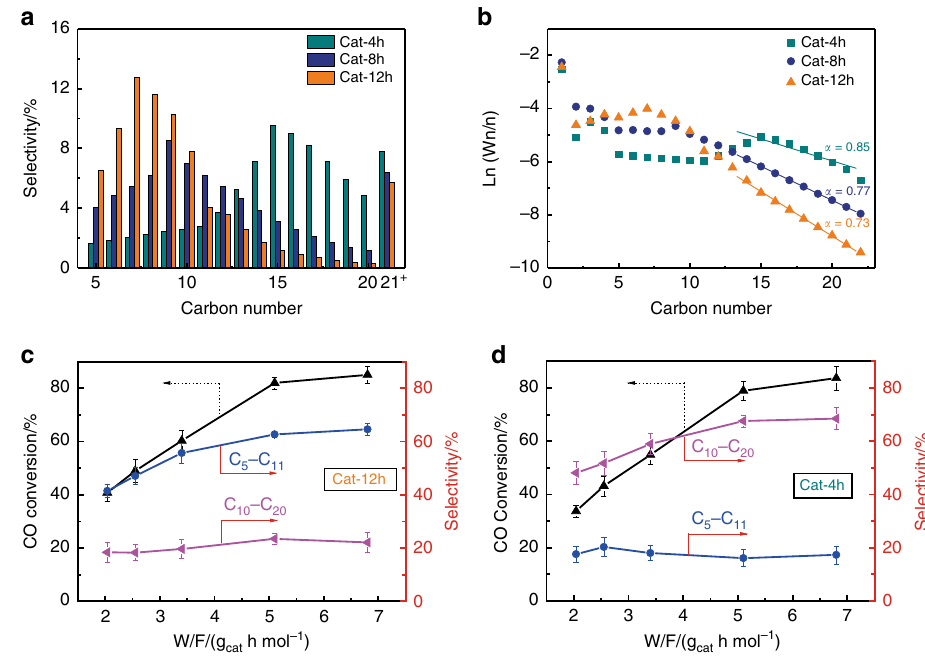
Fig. 5 FTS performance of the Cat- x h catalysts. a Distributions of the C 5 + products of the Cat- x h catalysts. b ASF distributions for the Cat- x h catalysts. Effect of contact time on activity and selectivity of c Cat-12h, and d Cat-4h. Reaction conditions: T = 220 °C, P = 2 MPa, W/F = 2.0-6.8 g cat h mol − 1 , CO/ H 2 = 1/2. Error bars indicate s.d. ( n = 5)